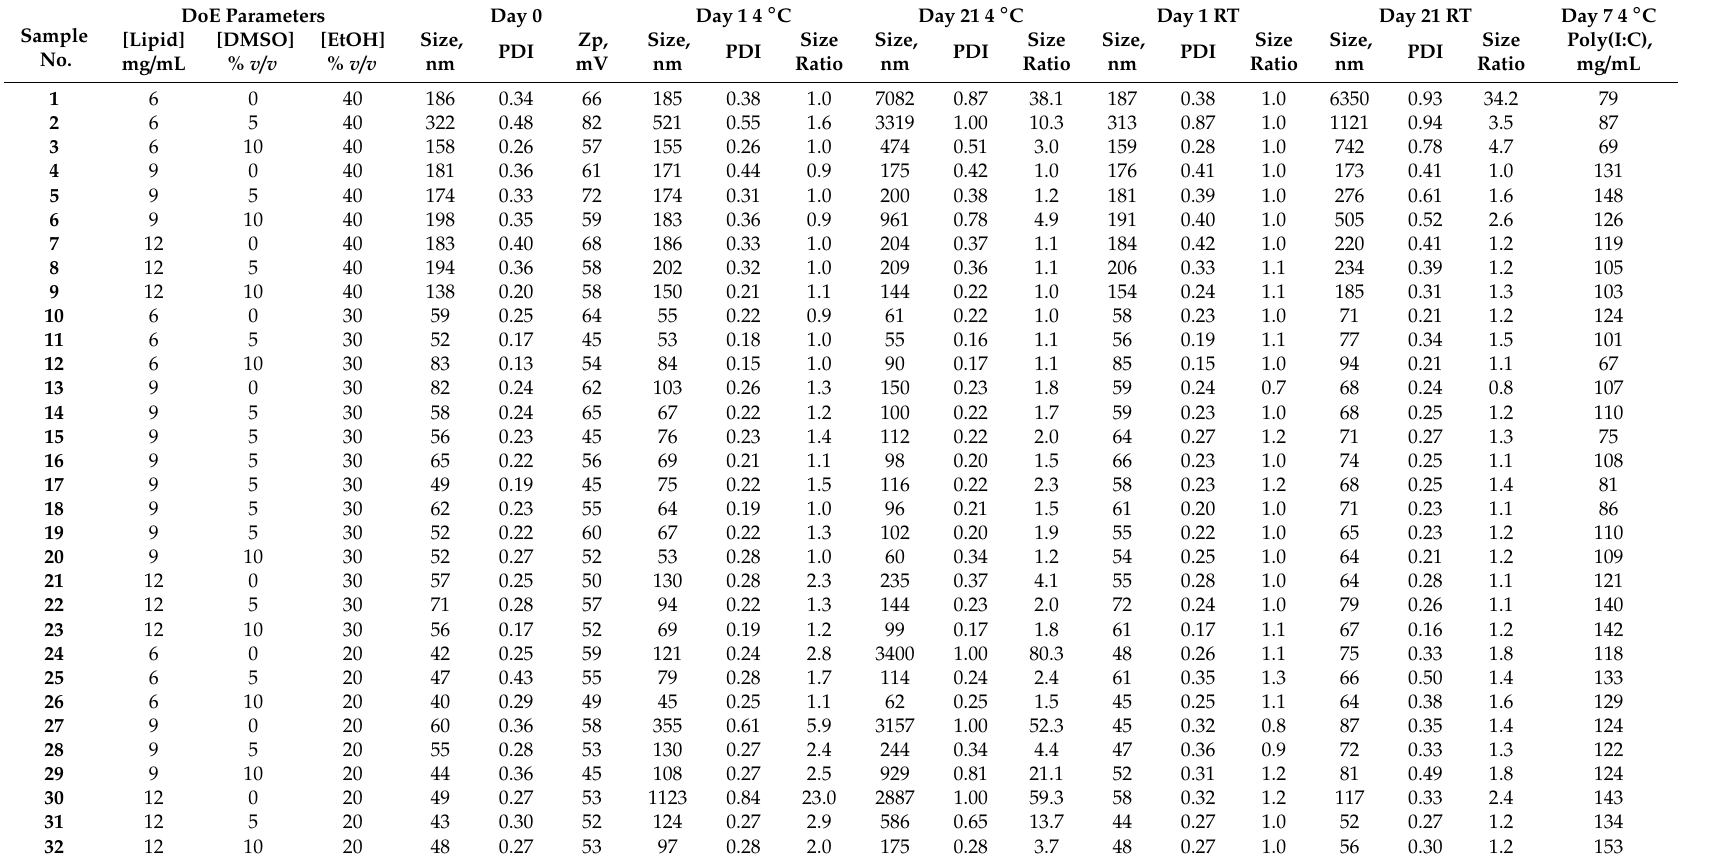
Table 2. The parameter settings employed in the DoE and the results used for response surface methodology (RSM) analysis. The concentrations of the parameters; lipid, DMSO and EtOH, were measured after formulation on the microfluidic chip but prior to dilution in the collection vial. The formulations were directly diluted to The samples were analyzed on the day of manufacture, Day 0, for particle size, polydispersity index (PDI) and zeta potential (Zp). On Day 1 and Day 21, the particle size was measured for samples stored at 4 ◦ C and RT, and the size ratio was calculated in relation to the particle size measured on Day 0. On Day 7, the concentration of poly(I:C) was measured on samples stored at 4 ◦